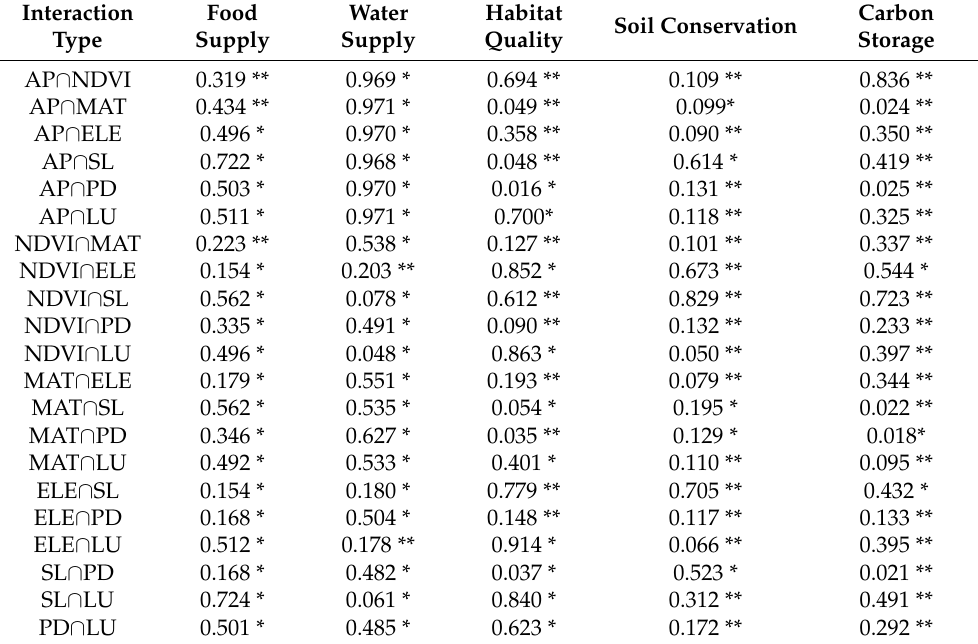
Table 3. Interaction detection results of ecosystem service factors in the western Sichuan Plateau. Interaction